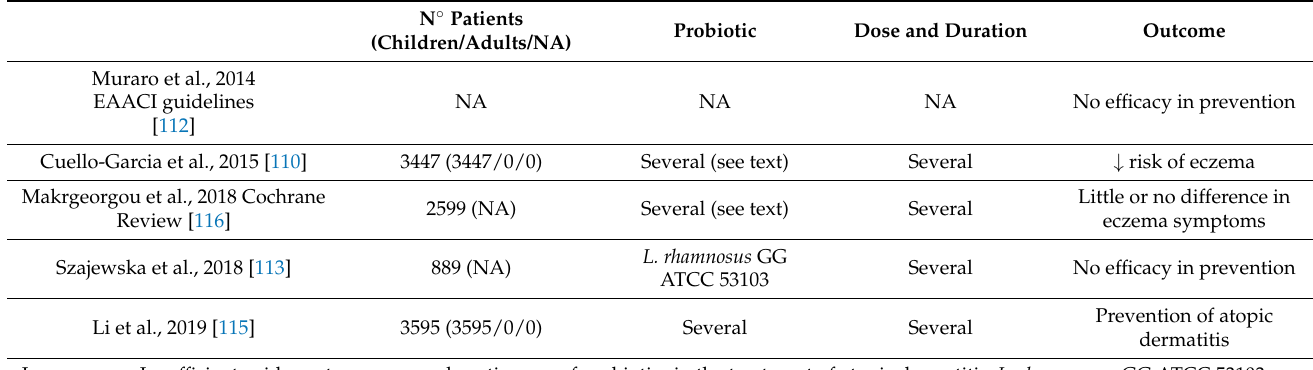
Table 14. Meta-analyses and systematic reviews on probiotics in atopic